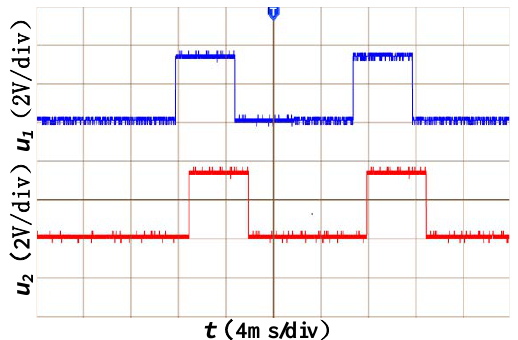
Figure 29. The transmitted data and demodulated data.